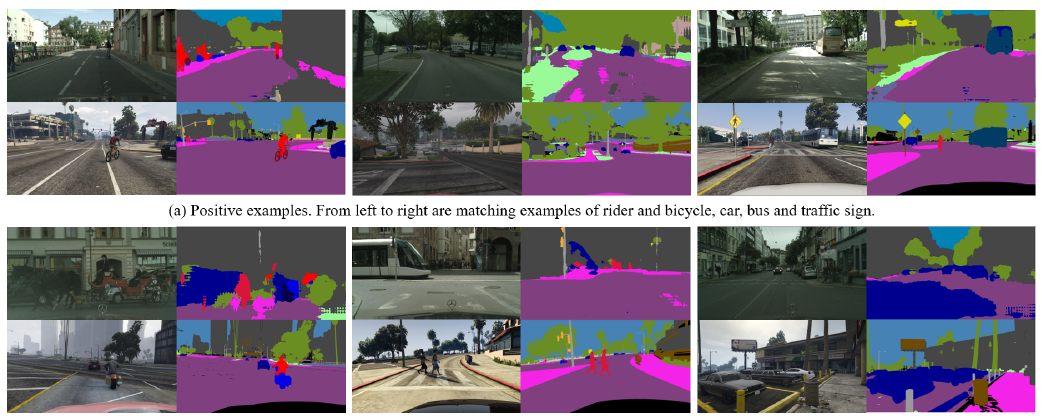
Figure 8. Positive matching examples and negative matching